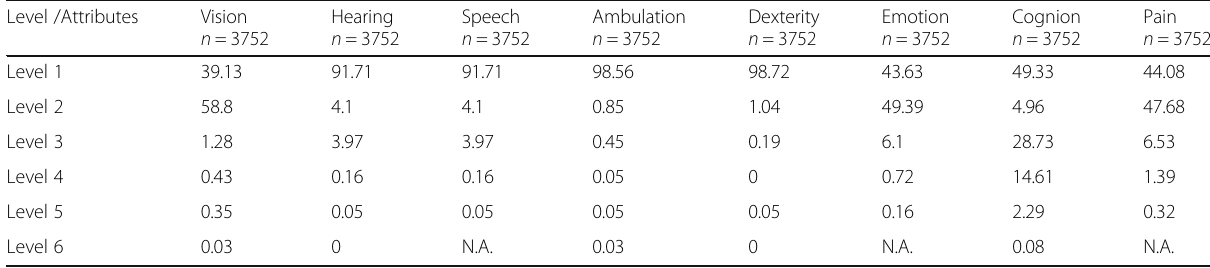
Table 2 Distribution of single attributes level by all age-group(%) Level /Attributes Vision Hearing n = 3752 n =